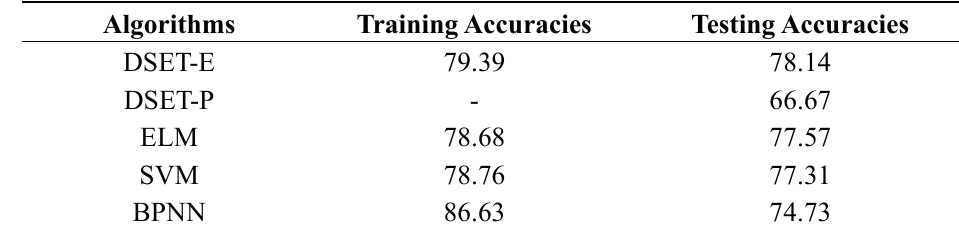
Table 2. Accuracy comparison for DIABETES data set (average, %).